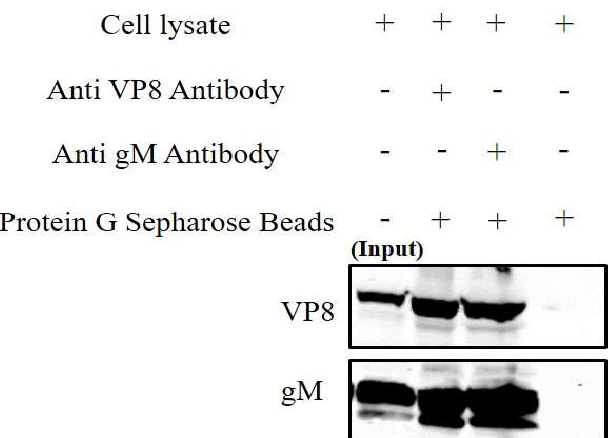
Figure 2. Identification of the glycoprotein interacting with VP8. Lysates from MDBK cells infected with WT BoHV-1 were incubated with rabbit VP8-specific antibody followed by Protein Sepharose G beads. After elution by SDS loading dye, the samples were subjected to SDS-polyacrylamide gel electrophoresis on an 8% (gB, gC, gD, gE, gH, gM) or 15% (gN, gL) gel and transferred to 0.45 µm nylon membranes. Glycoproteins were detected with antibodies specific for gB, gC, gD, gE, gH, gM, gN, or gL, followed by IRDye 680RD goat anti-mouse IgG and IRDye 800RD goat anti-rabbit IgG. Glycoprotein M was found to precipitate with VP8. A fraction of the whole cell lysate was used as input control. Glycoproteins B, gC, gD, gE, gH, gM, gN, and gL were all present in the infected cell lysate.